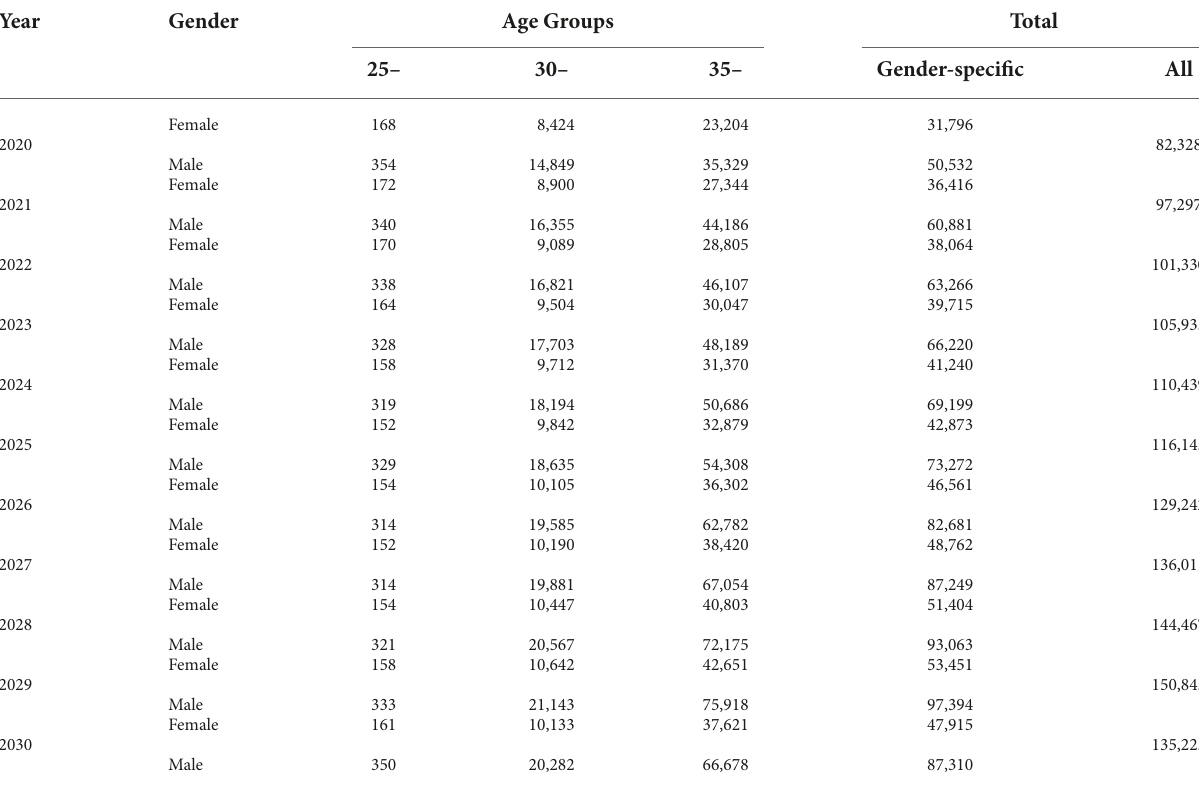
TABLE 4 Projected age-specific number of PD mortality in China by gender from 2020 to 2030 based on the BAPC framework a